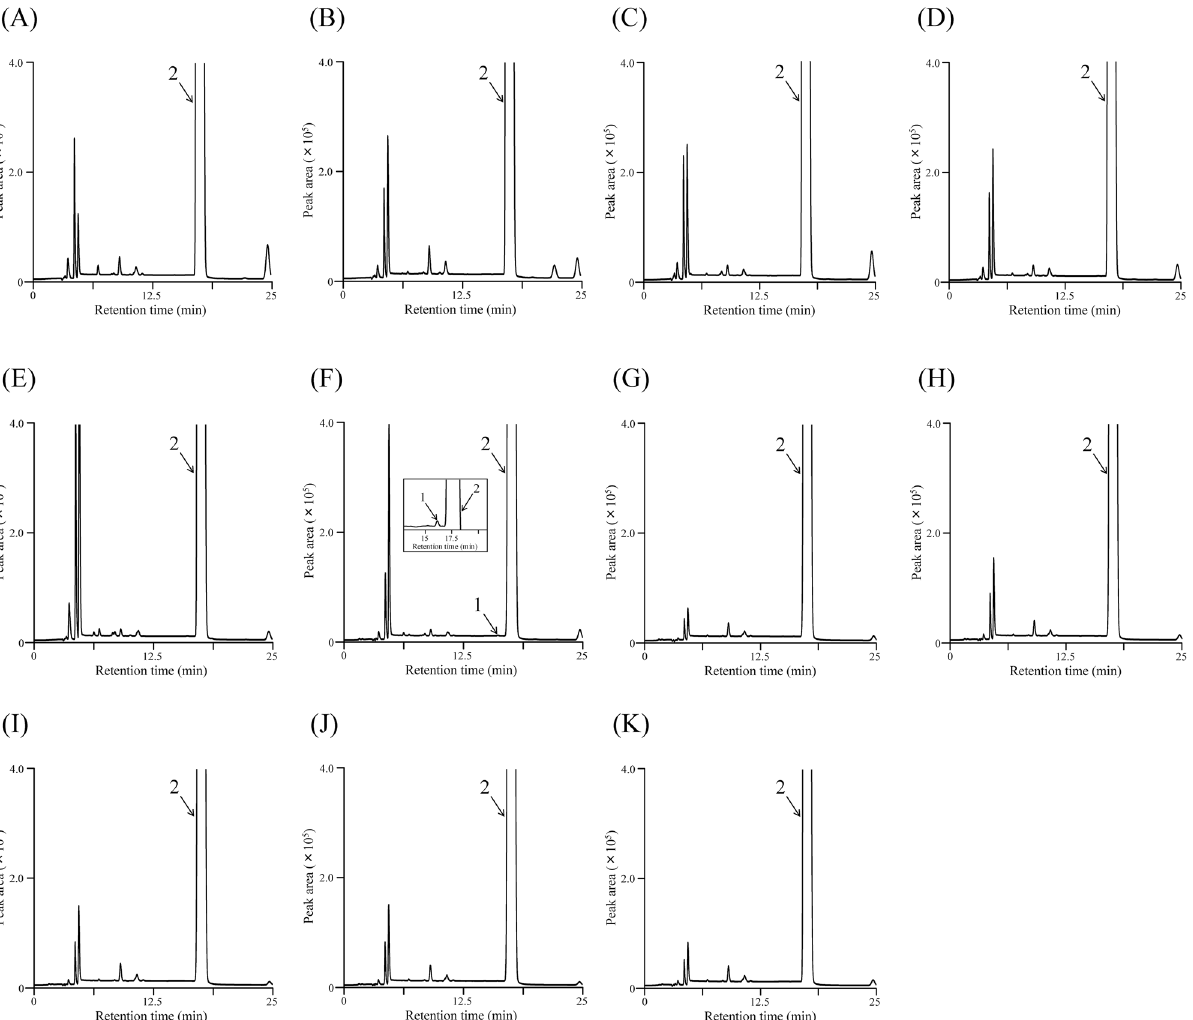
Fig 3. Representative HPLC chromatograms of commercially available L,L-APM samples. The peaks labeled 1 and 2 correspond to L, D-APM and L, L-APM, respectively. These peaks are highlighted in (F).